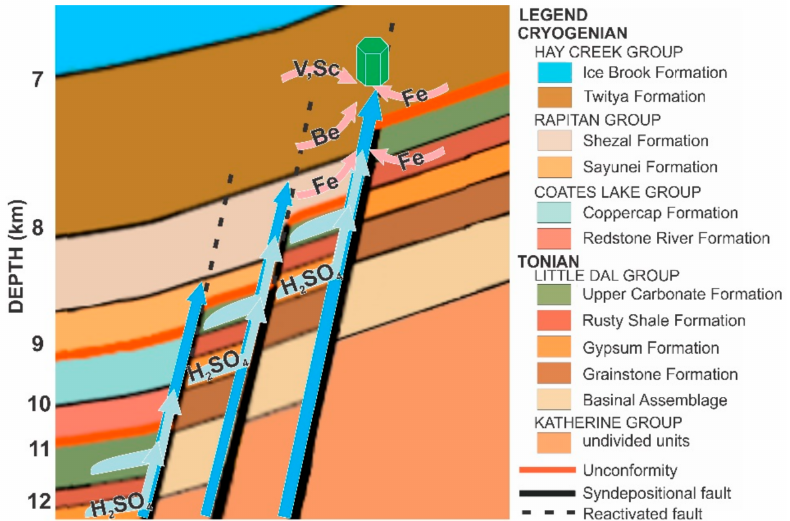
Figure 31. Idealized schematic model for the emerald mineralization of the Mountain River emerald occurrence located in Devonian to Mississippian platform sediments [117]. Emerald resulted from inorganic thermochemical sulphate reduction (light blue arrow) via the circulation of brines along a reactivated normal fault (dark blue arrow). The high-salinity brines result from the dissolution of evaporites lenses in the sediments. Be, V, Sc, and Fe were mobilized from the sedimentary formations (pinkish